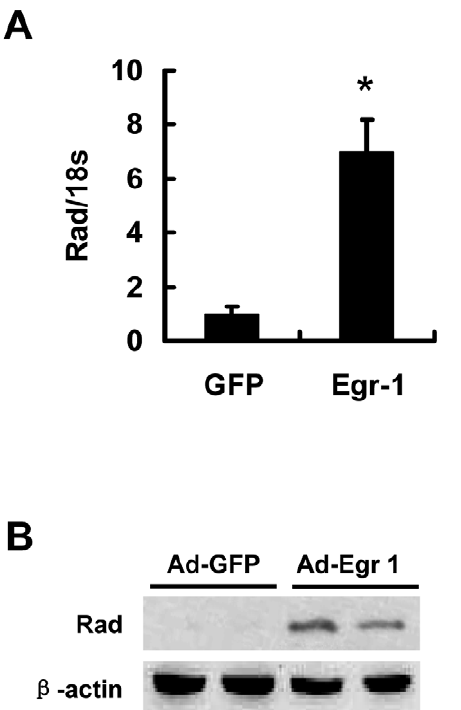
Figure 3. Egr-1 induces Rad expression. (A) RASMCs were infected with Ad-Egr-1or Ad-GFP for 24 hours. Rad mRNA levels were detected by real-time PCR (n=3, ** p , 0.01 vs. control); (B) Rad protein levels were determined by Western blotting analysis. Expression of b -actin was detected as the control for equal loading.